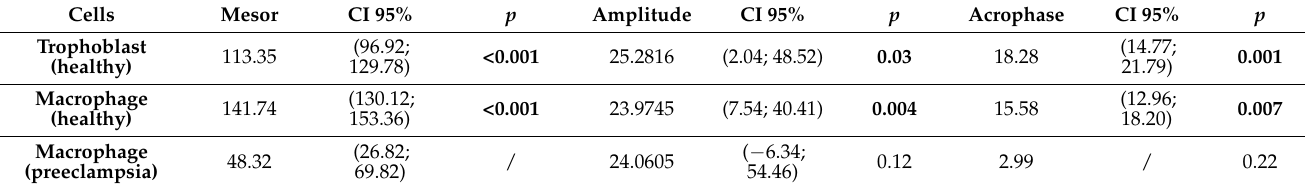
Table 3. Rhythmic parameters (mesor, amplitude, and acrophase) of melatonin (pg/mL) circadian expression. A p value < 0.05 for mesor, amplitude, and acrophase implies a rhythmicity of the investigated